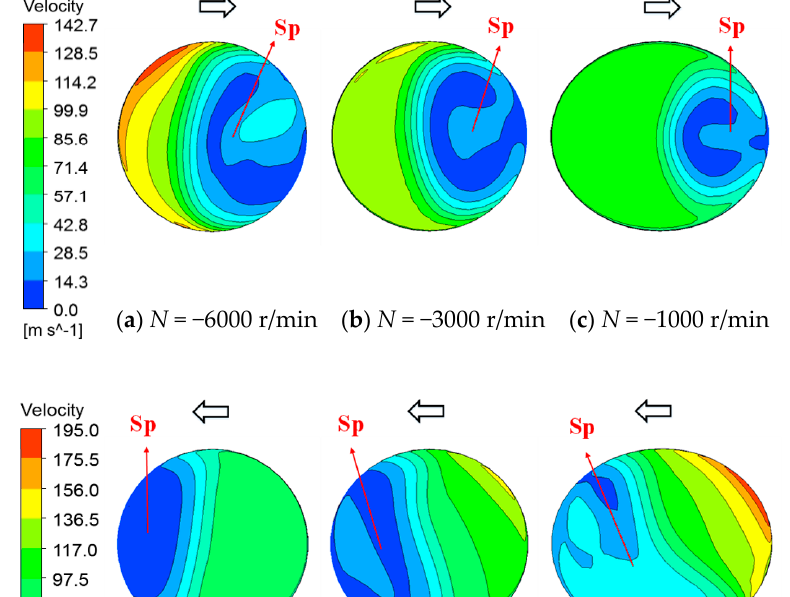
= 0.378, ( b ) 𝛽 (cid:2868) = d =0.632, ( e ) 𝛽 (cid:2868) d